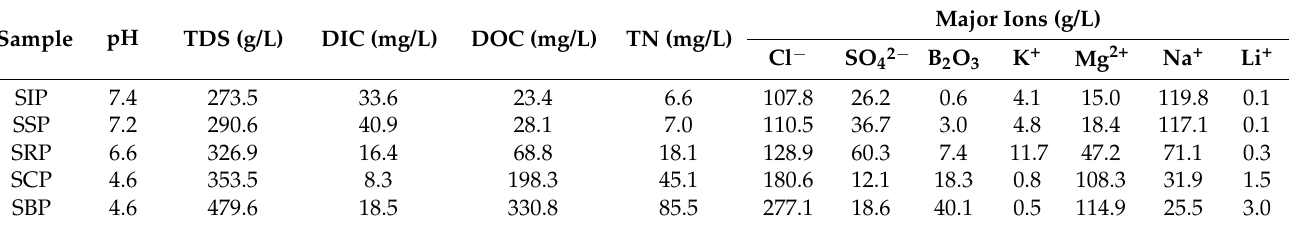
Table 1. Variations in physical properties and chemical compositions of the studied Salt Lake brine samples in the solar pond process.